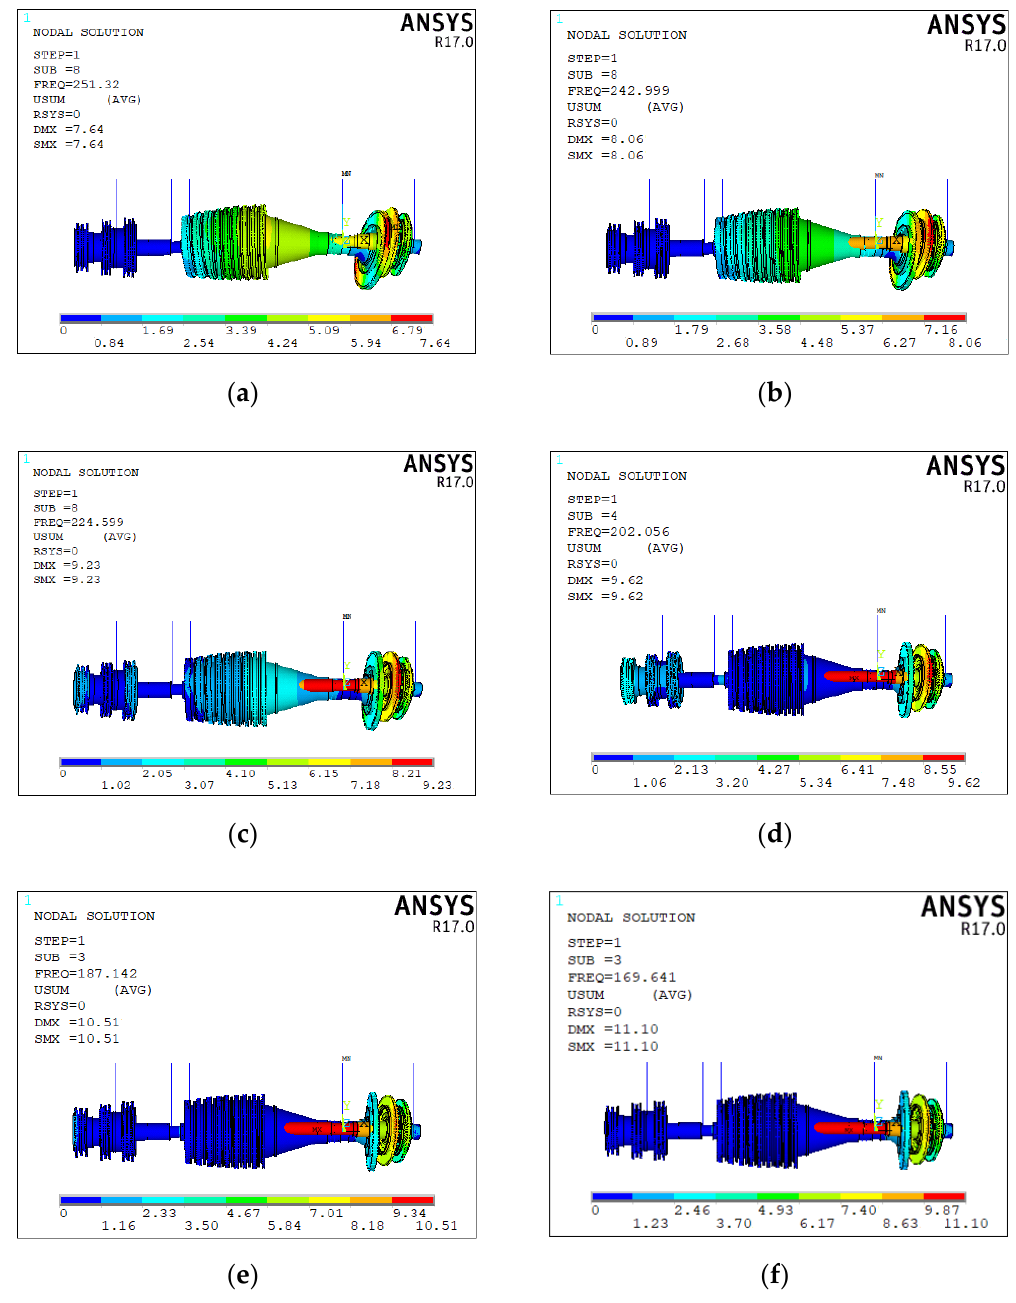
Figure 17. The 3rd order modal for contrast in different front deflection angle non-concentricity: ( a ) θ = 0.05 ◦ ; ( b ) θ = 0.1 ◦ ; ( c ) θ = 0.15 ◦ ; ( d ) θ = 0.2 ◦ ; ( e ) θ = 0.25 ◦ ; ( f ) θ = 0.3 ◦ . Table 7. The change rate of the natural frequency of the 5th